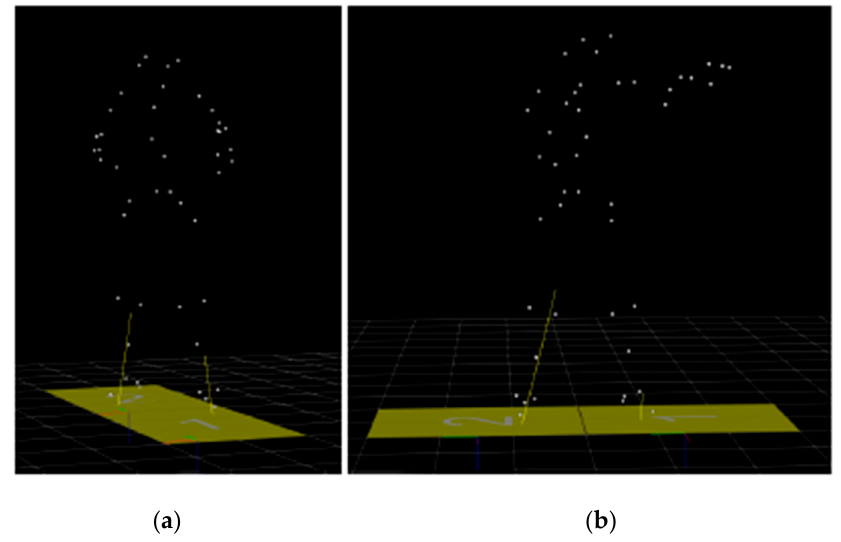
Figure 3 . Vicon motion capture testing: ( a ) preparation phase, ( b ) throwing phase . Figure 3. Vicon motion capture testing: ( a ) preparation phase, ( b ) throwing